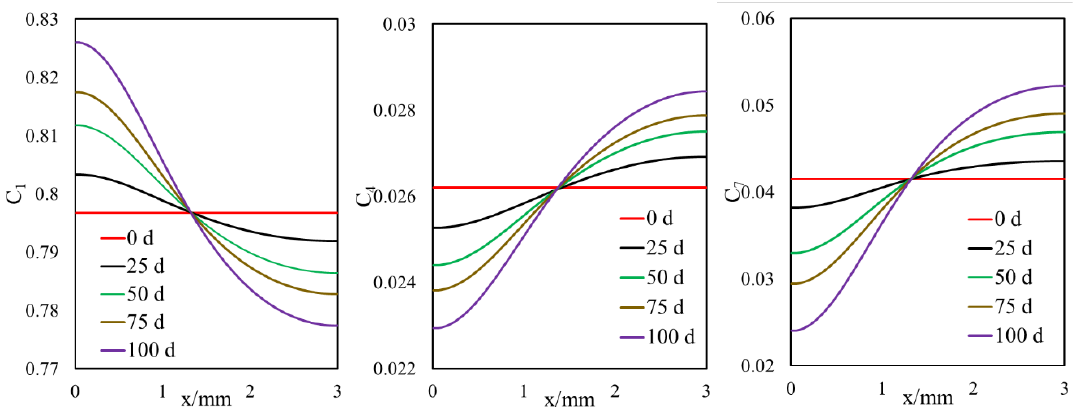
Figure 10. The overall composition of C 1 (left), C 4 (middle), C 7 (right) at different times, Marcellus shale condensate.